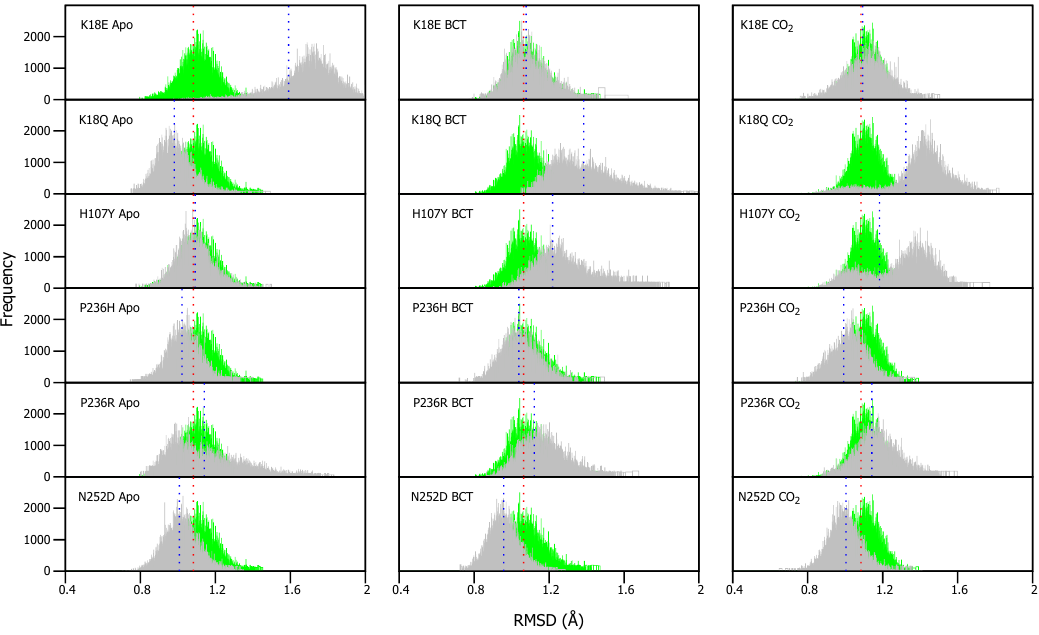
Figure 3. α -carbon RMSD distribution of the WT and variant proteins over the 200 ns MD simulation. The green and grey histograms indicate the RMSD distribution of the WT and variant protein, respectively. The red and blue dashed lines represent the mean RMSD of the WT and variant proteins, respectively. Variant apo, BCT and CO 2 proteins are each plotted against the WT apo, BCT and CO 2 bound proteins, respectively. The x-axis represents RMSD of sampled conformations during MD simulation, whereas the y -axis (Frequency) represents number of times a specific conformation was